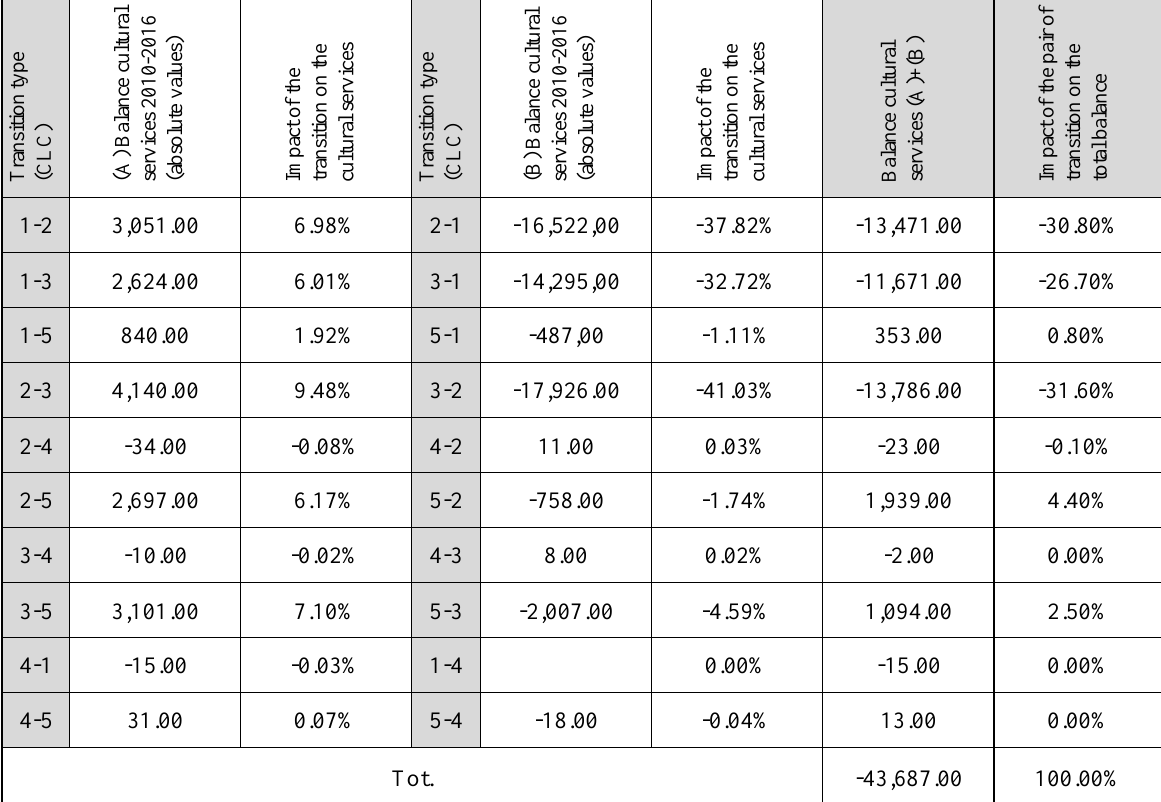
Table 9. Transition 2010-2016 of cultural: contributions of transitions between different LULC classes at the first classification level.